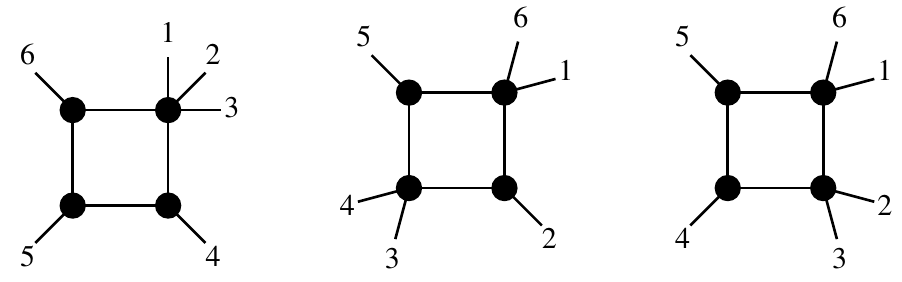
Figure 3 . One-mass, two-mass easy and two-mass hard